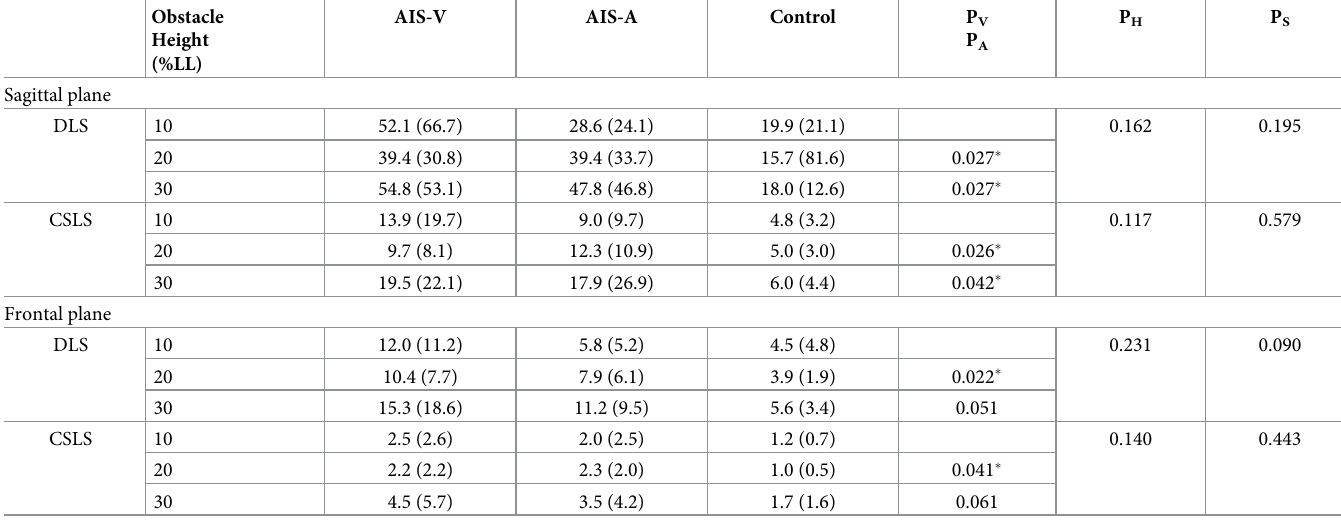
Table 4. Means (standard deviations, SD) of the jerk index (10 5 ˚/s 3 ) of the sagittal and frontal IA in the patients with adolescent idiopathic scoliosis and healthy controls when crossing obstacles of heights of 10%, 20% and 30% of subjects’ leg